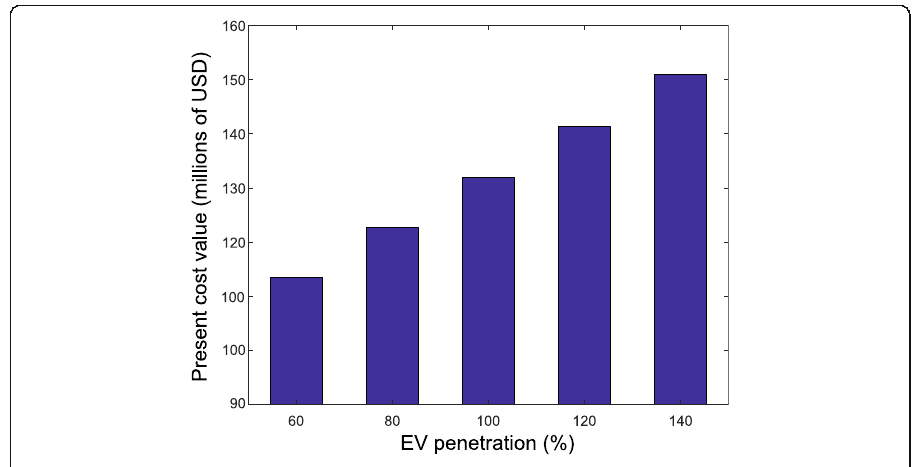
Fig. 6 Sensitivity analysis with different EVs penetrations (Case